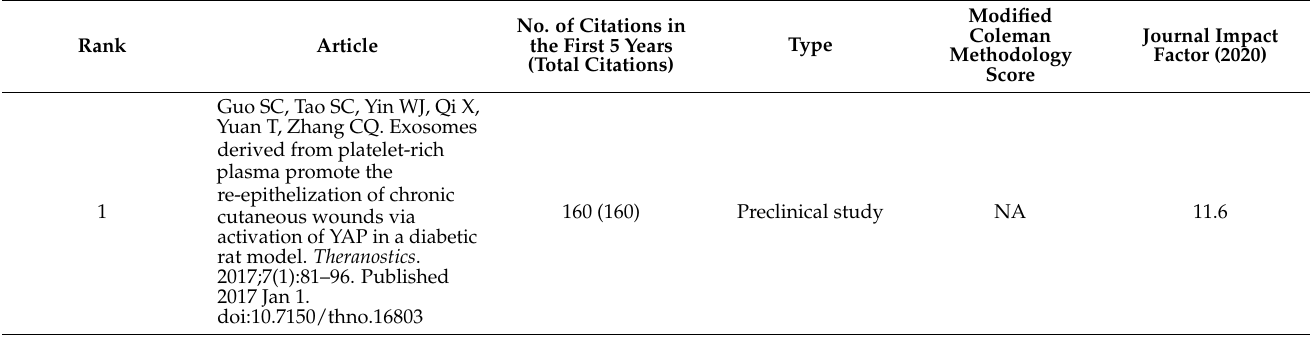
Table 6. Promising articles based on the number of citations in the first five years from publica- tion.